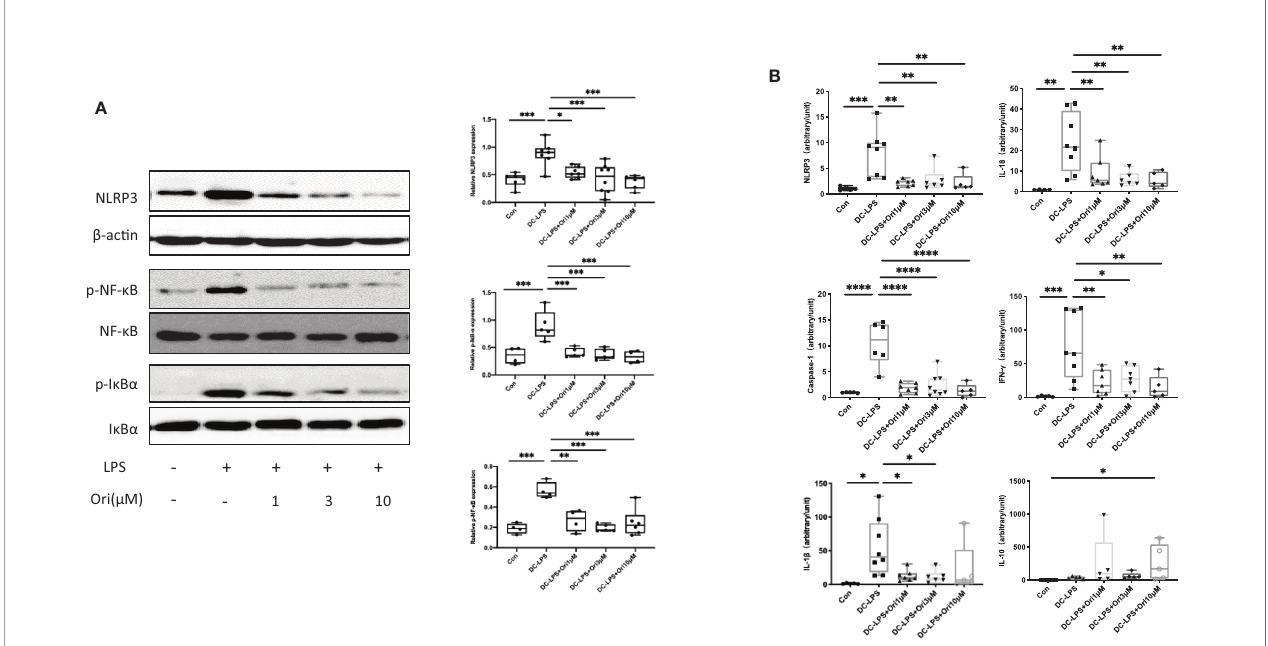
FIGURE 8 | Effects of Ori on the expression of NLRP3/I k -B/NF- k B and relative expression of mRNA in BMDCs. BMDCs were induced from bone marrow cells with IL-4 (10 ng/ml) and GM-CSF (10 ng/ml) in vitro . Different groups of BMDCs were treated with vehicle control, LPS 10 ng/ml (DC with LPS), and Ori 1, 3, and 10 m M (DC with LPS + Ori) for 48 h Different groups of BMDCs were harvested on Day 7. The expression of protein and mRNA was extracted and measured by Western blotting and qRT-PCR, respectively. (A) Western blot analysis of NLRP3, p-I k -B, I k -B, p-NF- k B, NF- k B, and b -actin proteins in each group. Bar graphs show the relative expression with ratios of NLRP3/ b -actin, p-NF- k B/NF- k B, and p-I k -B/I k -B for each sample. Statistical analysis was determined by one-way ANOVA. * p < 0.05, ** p < 0.01, *** p < 0.001, **** p < 0.0001. (B) The relative mRNA expression of NLRP3, Caspase-1, IL-1 b , IL-18, IFN- g , and IL-10 normalized with 18S for